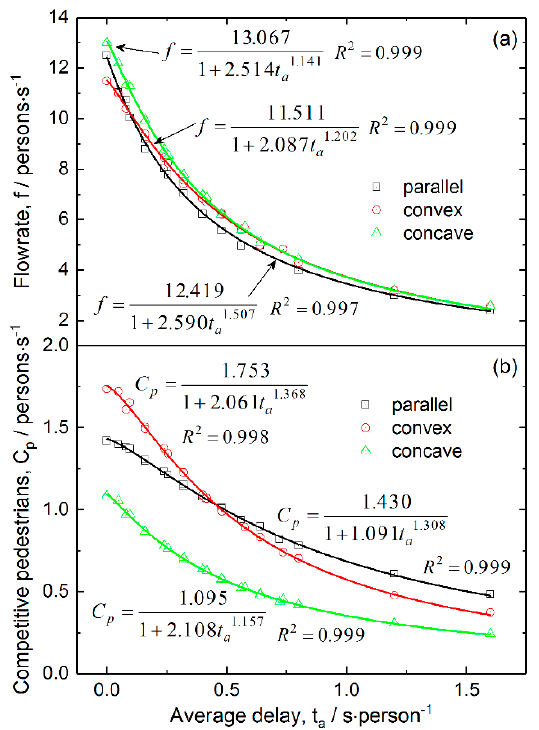
Figure 12. Dependence of ( a ) total pedestrian flowrate and ( b ) competitive pedestrian-time on integrated average delay for the three layouts. The lines are fitted from the data with the proposed model.